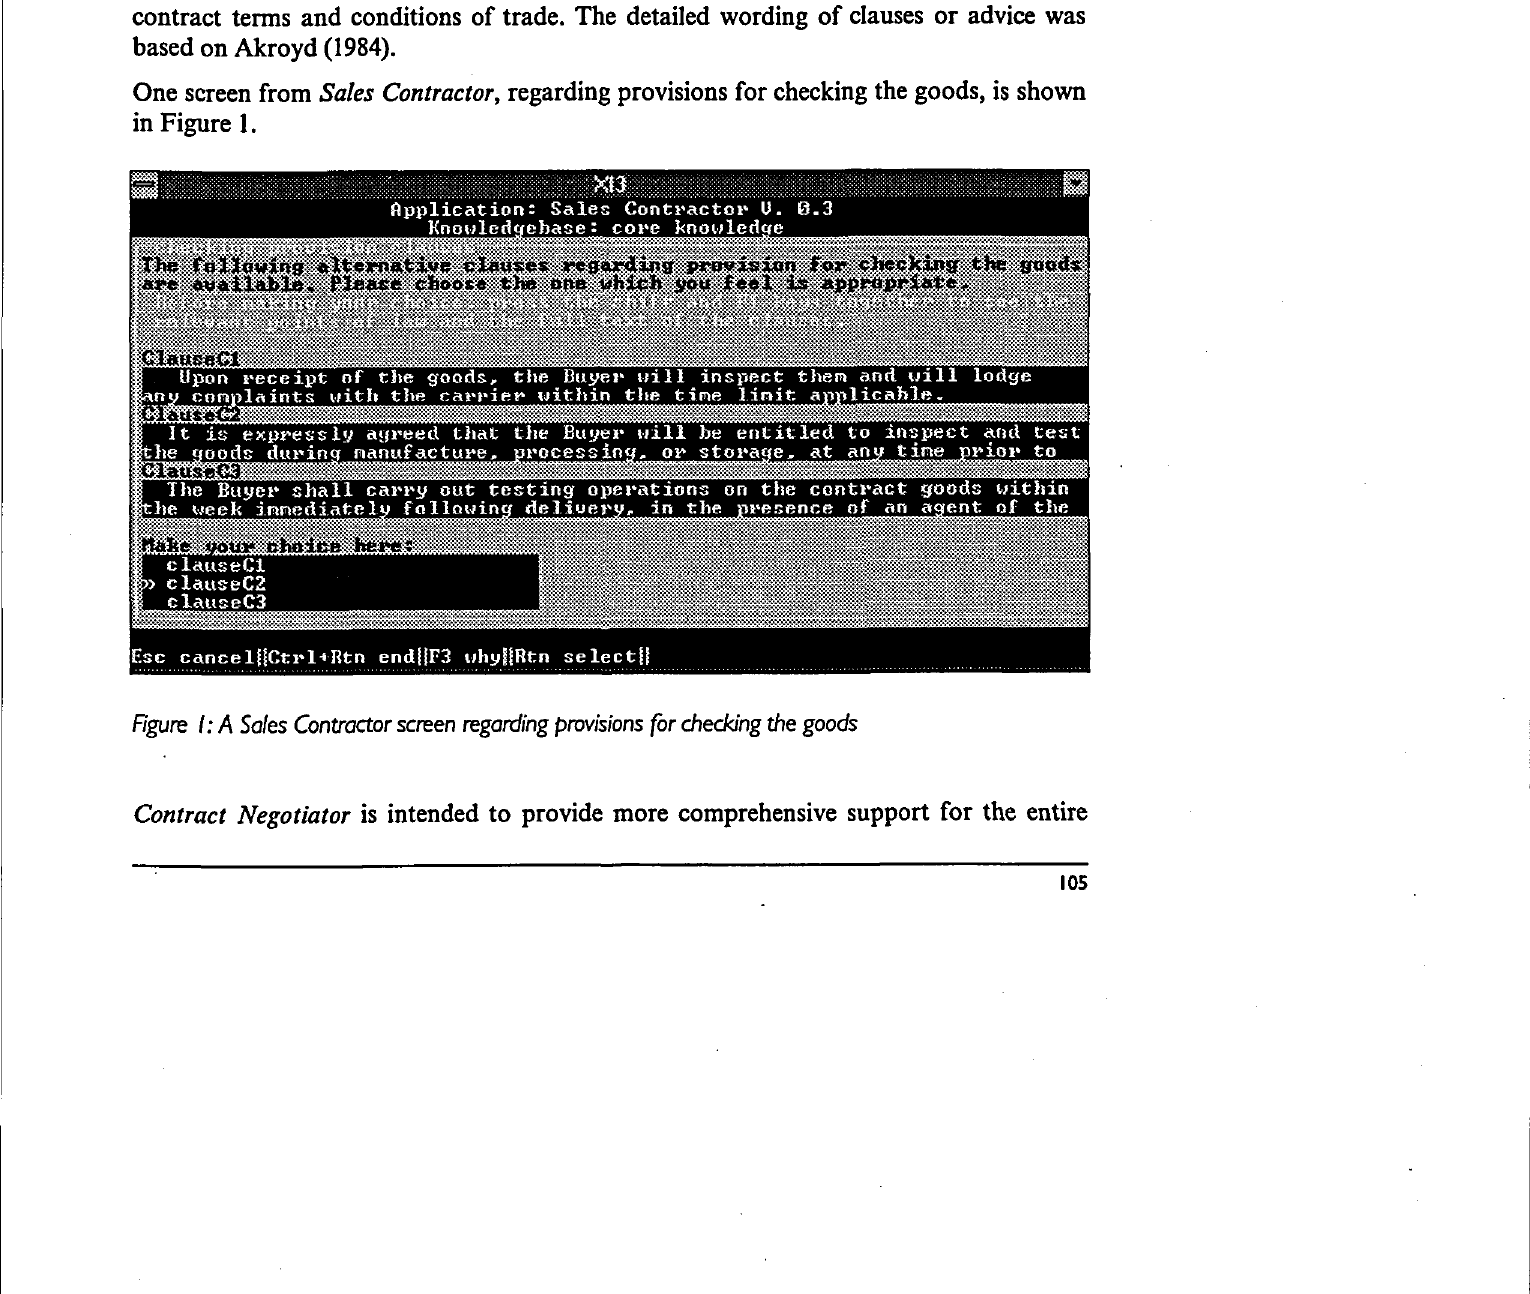
figure /: A Saks Contractor screen regarding provisions for checking the